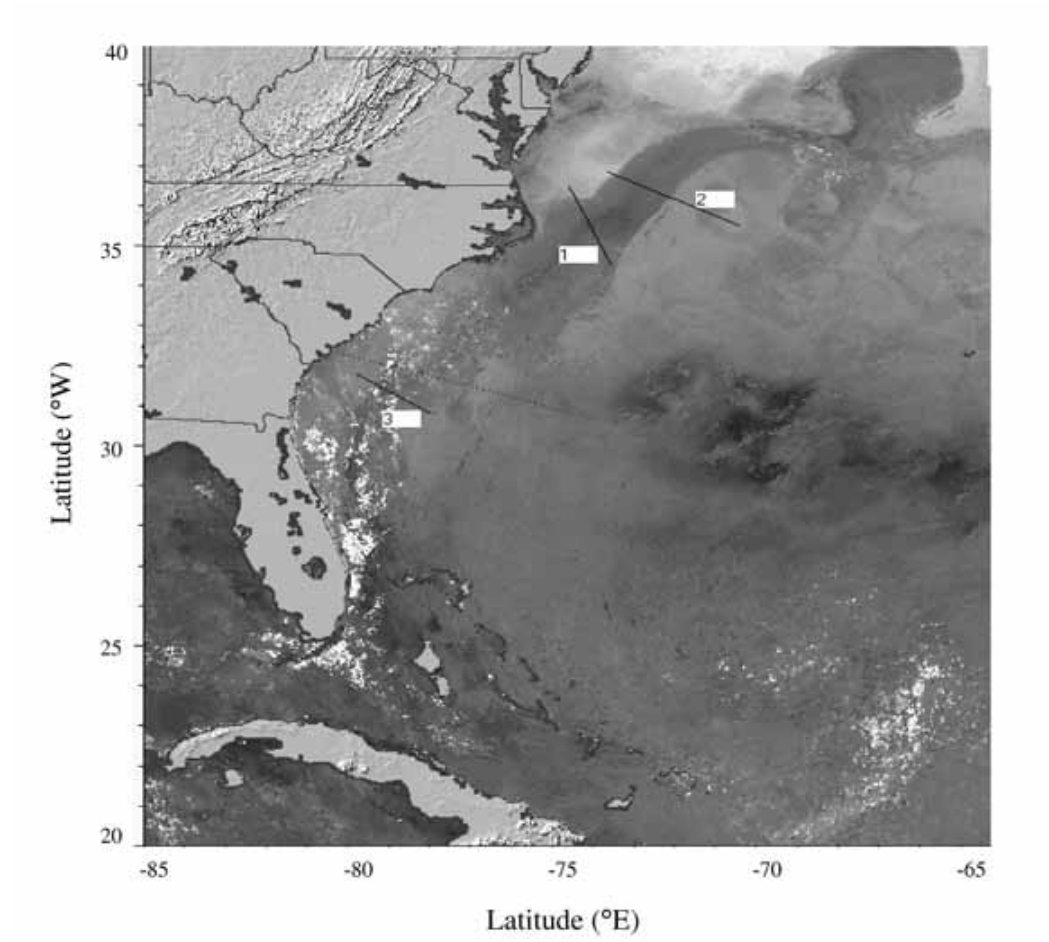
F IG . 2. – Location of all three data-set transects over a grey-coloured sea-surface temperature satellite image (available from the National Oceanic and Atmospheric Administration web page) that shows the path of the Gulf Stream as a band of relatively warm (dark)